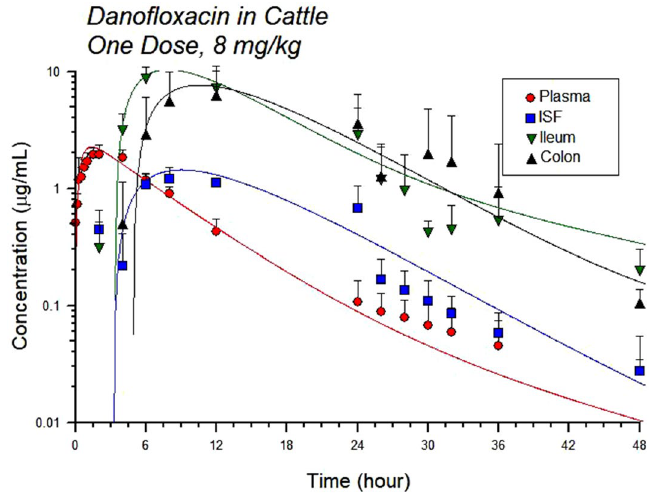
Figure 2. Total concentration of danofloxacin in plasma, interstitial fluid (ISF), ileum and colon ultrafiltrate dosed at 8 mg/kg once . Each point represents the mean and the error bars represent the standard deviation. The circle indicates plasma concentrations, the square indicates ISF concentrations, the upside down triangle indicates ileum ultrafiltrate concentrations and the right side up triangle indicates colon ultrafiltrate concentrations. The data is presented on a semi-logarithmic axis. The solid lines represent the predicted concentration based on the model fit. The actual values are the solid points.